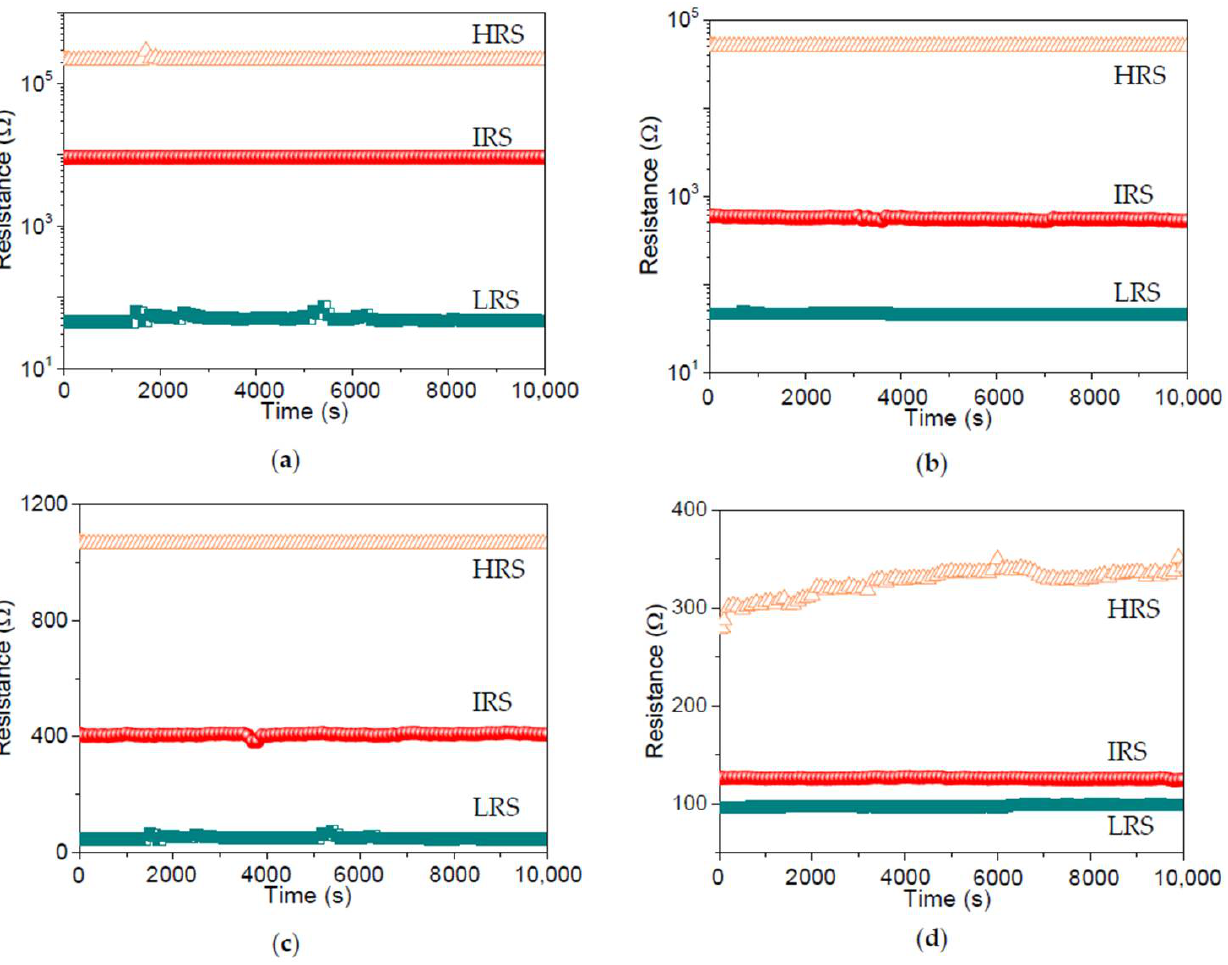
Figure 11. Retention tests conducted at R HRS , R IRS , and R LRS of ( a ) ITO/B1/Ni, ( b ) ITO/B2/Ni, ( c ) ITO/B3/Ni, and ( d ) ITO/B4/Ni without evident changes for over 10 4 s. ( c ) ITO/B3/Ni, and ( d ) ITO/B4/Ni without evident changes for over 10 4